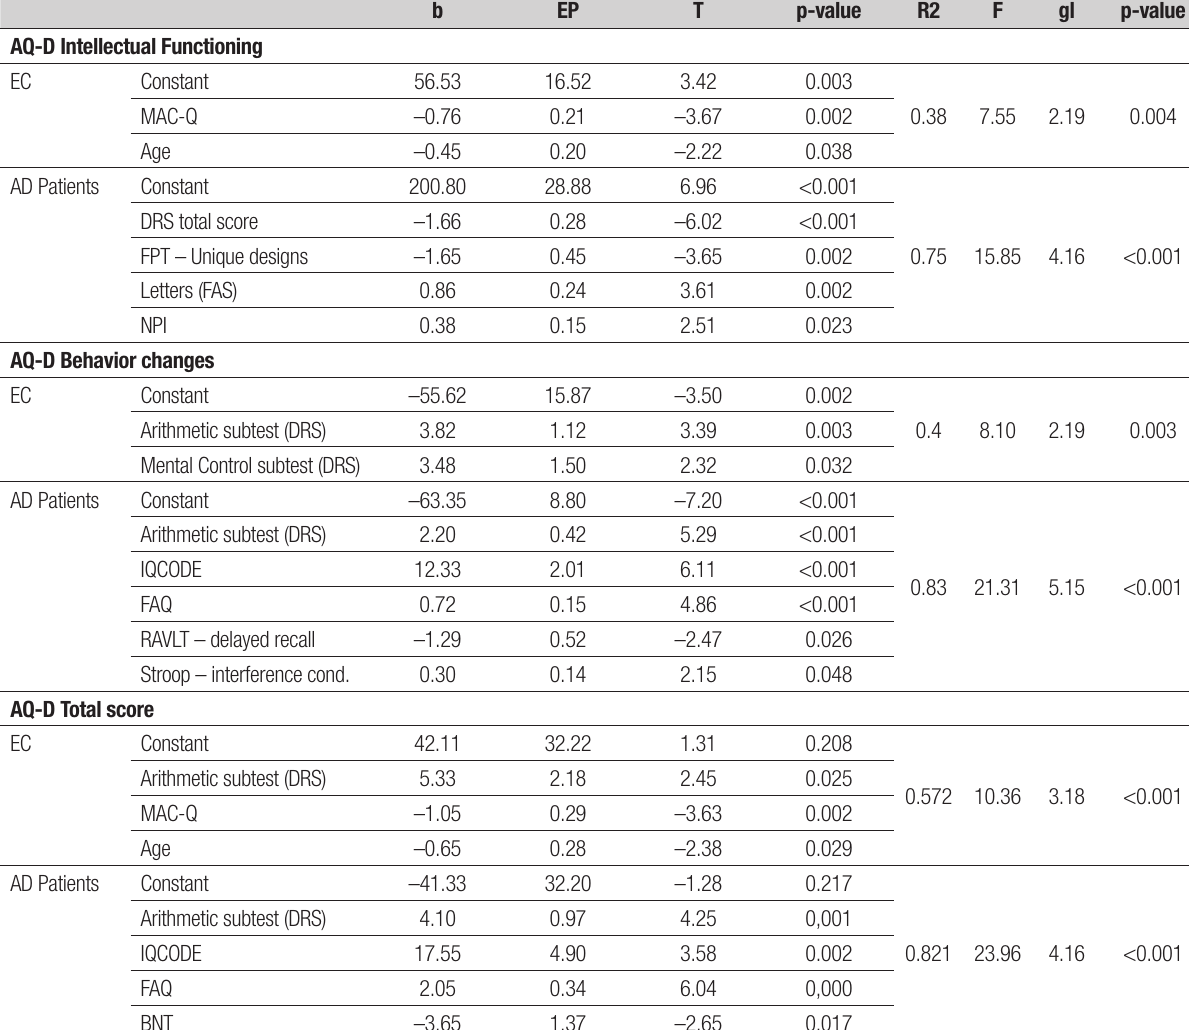
Table 3. Significant variables associated with anosognosia